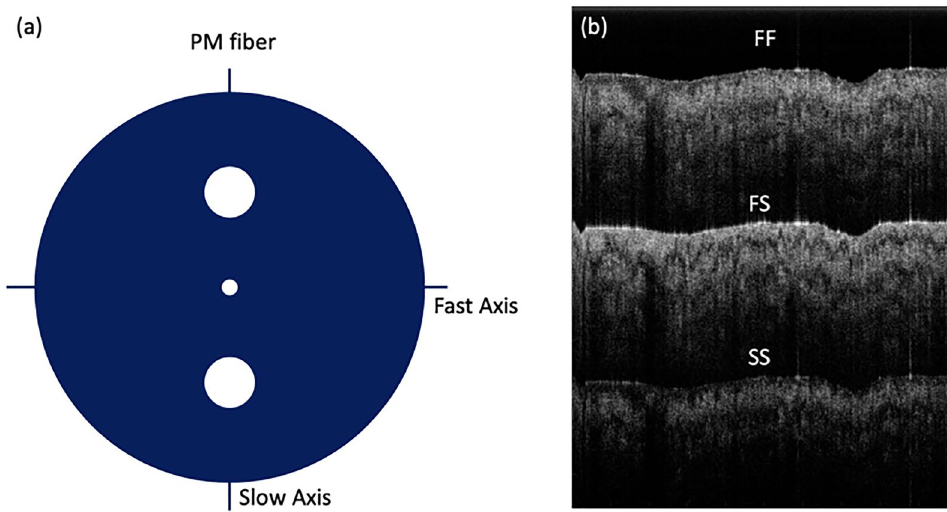
Figure 4. Definition of PMF axes ( a ) and FF, FS, and SS image replicas obtained by our IV-PSOCT system ( b ). Figure ( a ) is generated by using PowerPoint (Version 16.58, https:// www. micro soft. com/ en- us/ micro soft- 365/ power point). Figure ( b ) generated by using Matlab R2021a (Version: 9.10.0.1602886, https:// www. mathw orks. com/ produ cts/ new_ produ cts/ relea se202 1a.